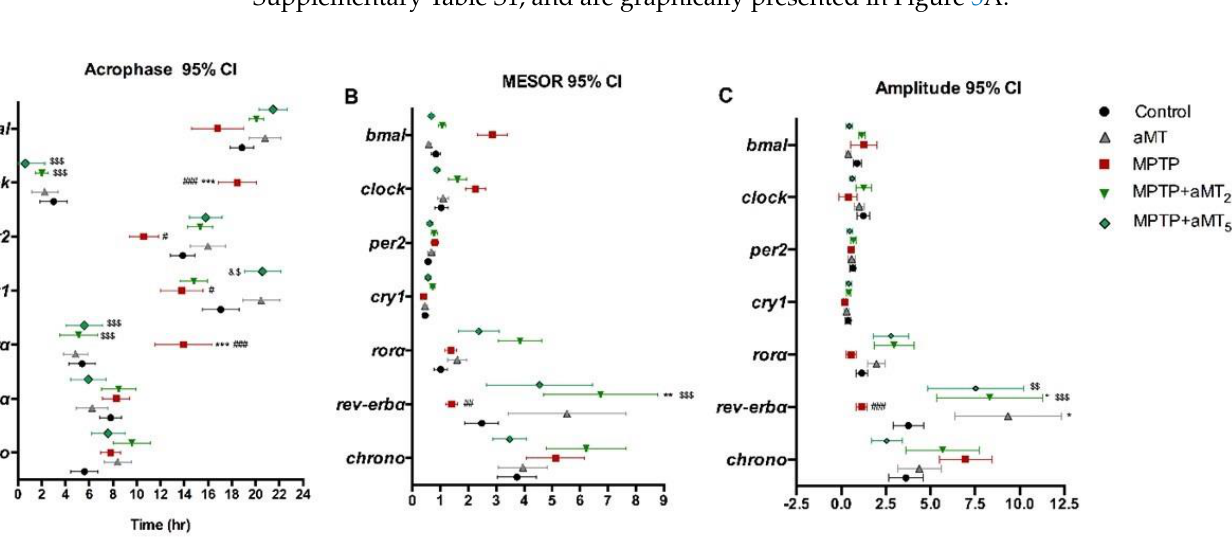
Figure 5. Graphical presentation of the cosinor parameters of the genes analyzed. ( A ) The acrophase, ( B ) Mesor, and ( C ) Amplitude chart of clock genes bmal1 , clock , per2 , cry1 , rorα , rev-erbα , and chrono . Data are expressed as mean ± SEM. * p < 0.05 vs. control; ** p < 0.01 vs. control; *** p < 0.001 vs. control; # p < 0.05 vs. aMT; ## p < 0.01 vs. aMT; ### p < 0.001 vs. aMT; $ p < 0.05 vs. MPTP; $$ p < 0.01 vs. MPTP; $$$ p < 0.001 vs. MPTP; & p < 0.05 vs. MPTP+aMT2. Two-way ANOVA with a Tukey’s post hoc